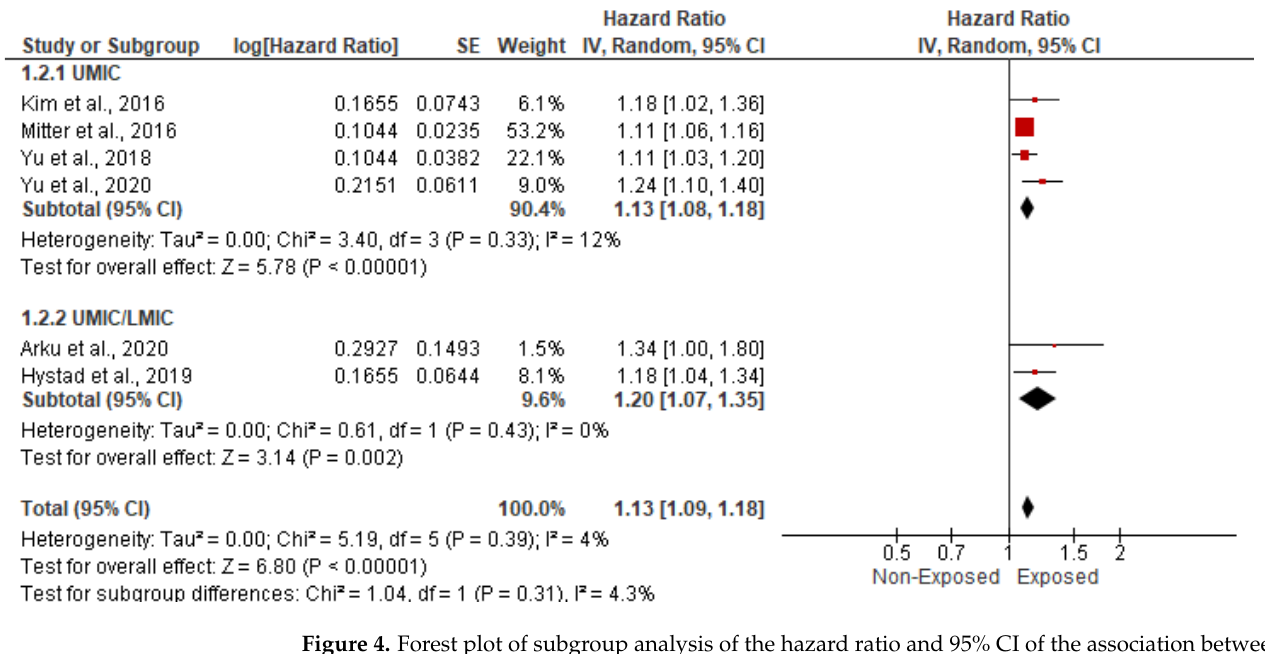
Figure 4. Forest plot of subgroup analysis of the hazard ratio and 95% CI of the association between HAP and CVD-related mortality based on income category. The size of the red squares is proportional to the statistical weight of each trial. The gray diamond represents the pooled point estimate. The positioning of both diamonds and squares (along with 95% CIs) beyond the vertical line (unit value) suggests a significant outcome (IV = inverse variance).